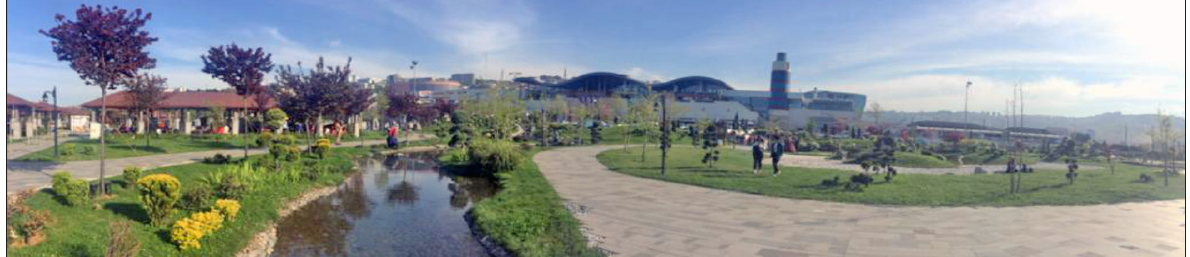
Figure 1. Study area